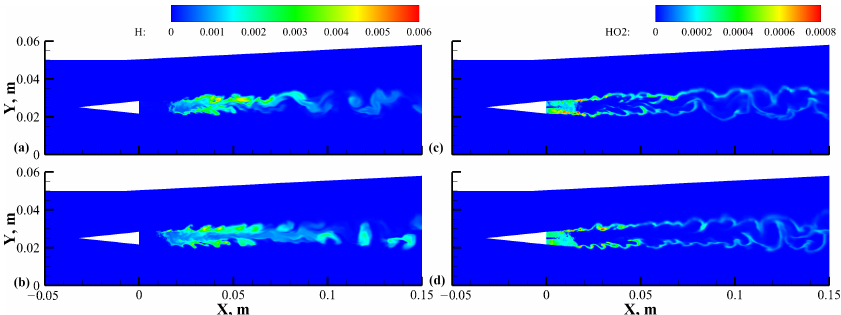
Figure 20. Contours of the mass fraction distributions of the H radical using the original and modified schemes ( a ) M1 and ( b ) M2; and the mass fraction distributions of the HO 2 radical using these two schemes ( c ) M1 and ( d )